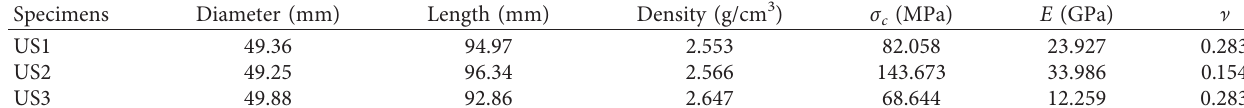
Table 1: Basic information and testing results of roof sandstone